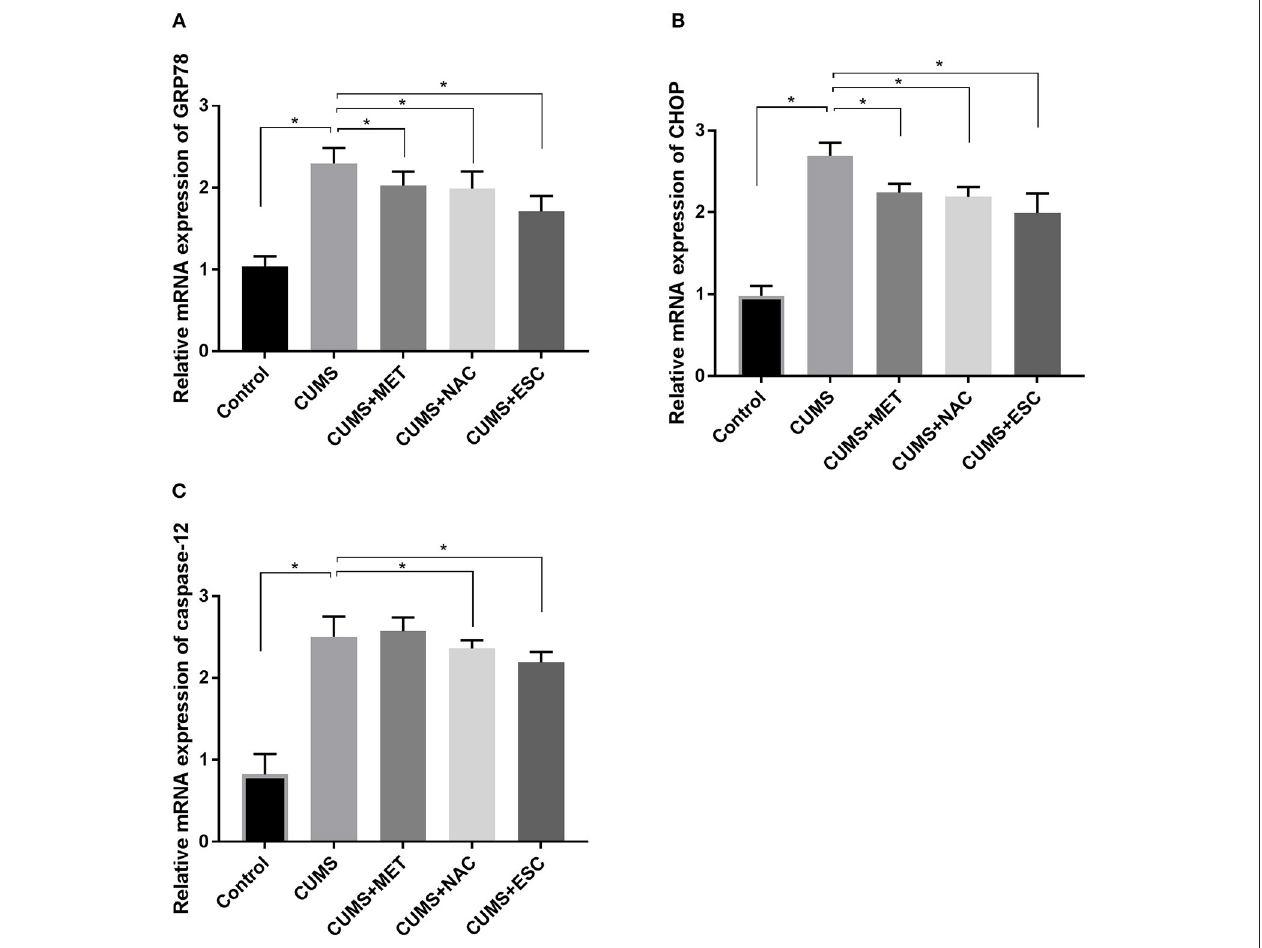
FIGURE 5 | Effect of MET, NAC, and ESC on the mRNA levels of ERS markers in CUMS-induced rats. (A) The relative mRNA expression of GRP78 in hippocampus of each group after stress. (B) The relative mRNA expression of CHOP in hippocampus of each group after stress. (C) The relative mRNA expression of caspase-12 in hippocampus of each group after stress. * P < 0.05 (one way ANOVA), n = 9.